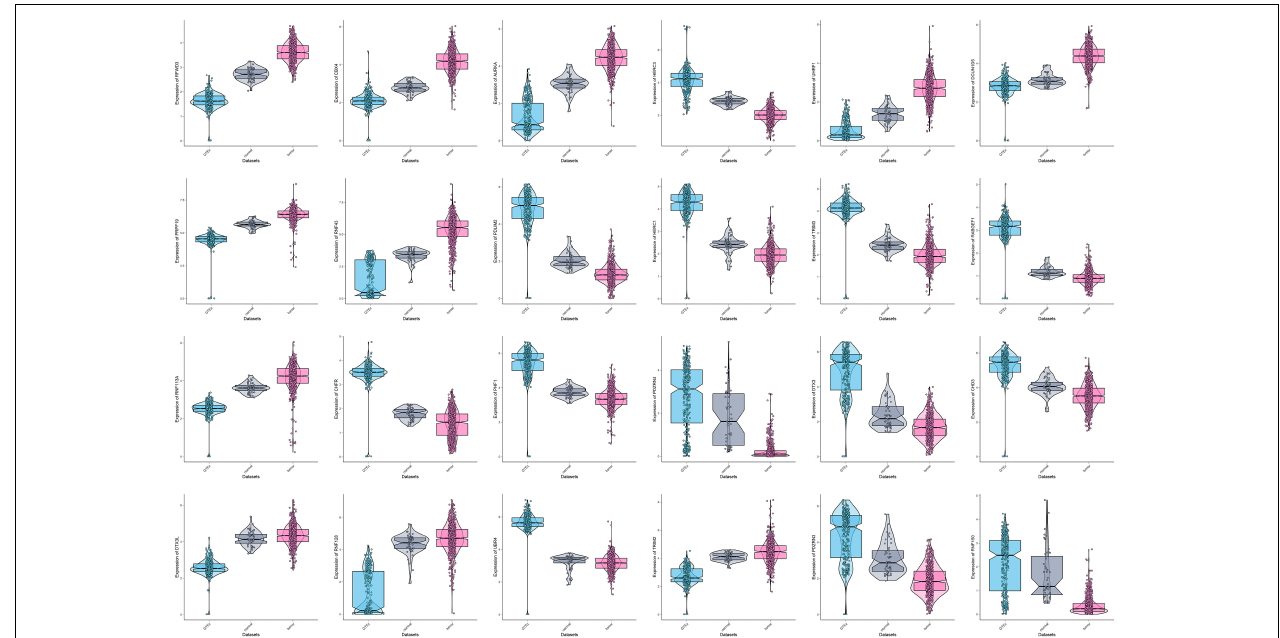
FIGURE 3 | The expression pattern of 24 differentially expressed E3 genes in three subgroups of datasets.